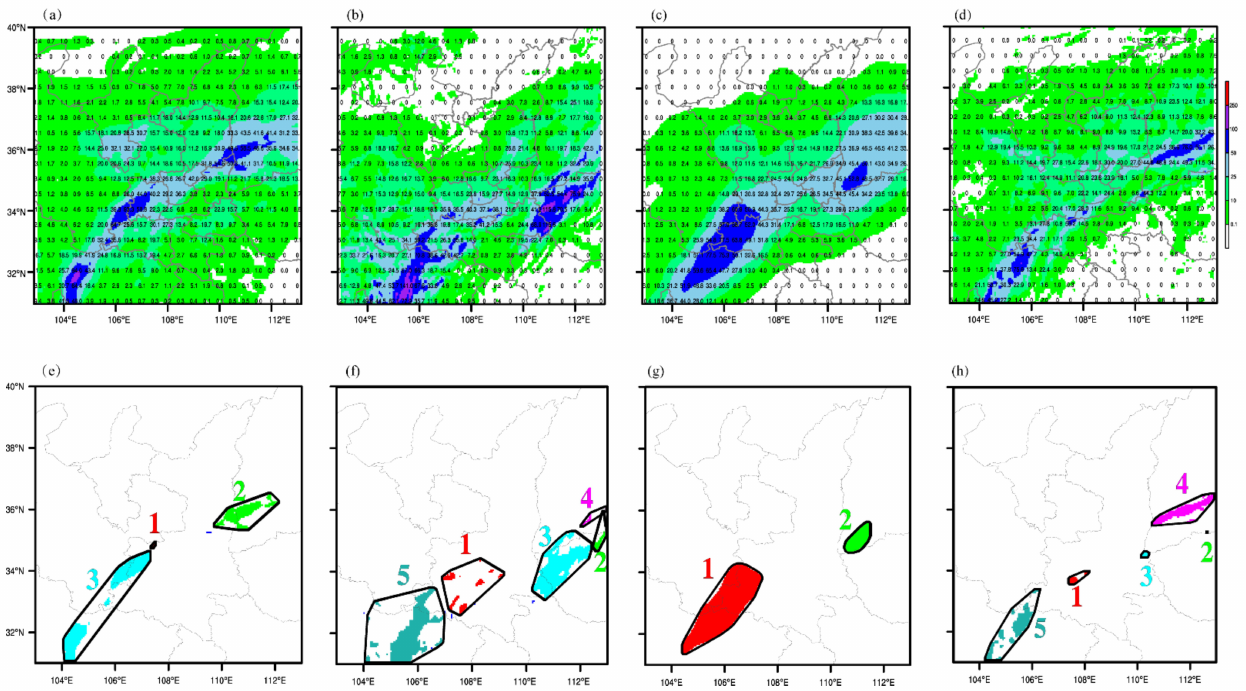
Figure 4. MODE method verification of individual rainstorm weather cases from 00 UTC on 14 Au- gust to 00 UTC on 15 August 2020: ( a ) ECMWF mode at 12 UTC on 13 August. ( b ) CMA-Meso mode at 12 UTC on 13 August. ( c ) SCMOC guidance forecast. ( d ) CMPA. ( e – h ) These are the rainstorm objects identified in the ECMWF, CMA-Meso, SCMOC, and CMPA precipitation fields,